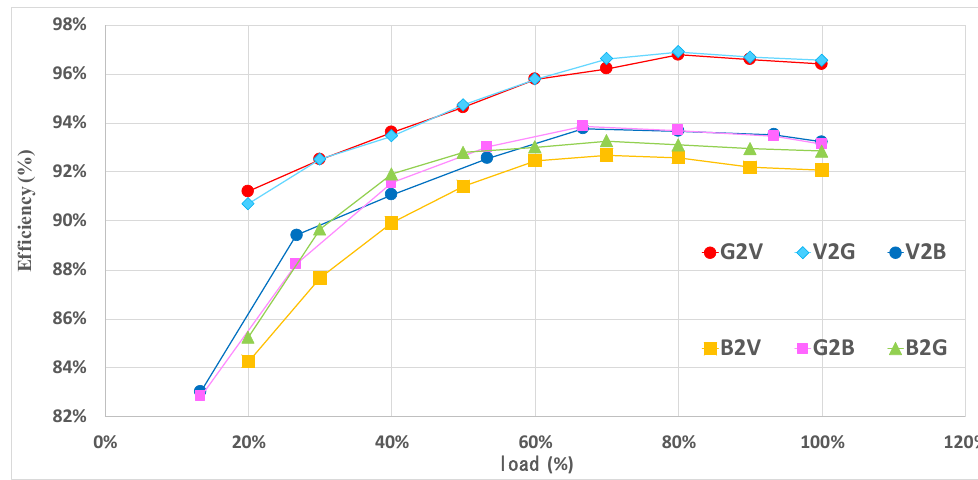
Figure 19. Efficiencies of the six operating modes.